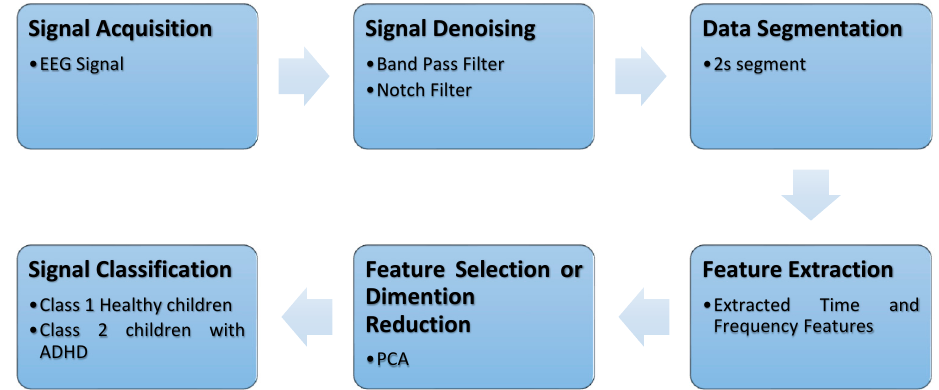
Figure 2. The pipeline for EEG signal classification employed in this